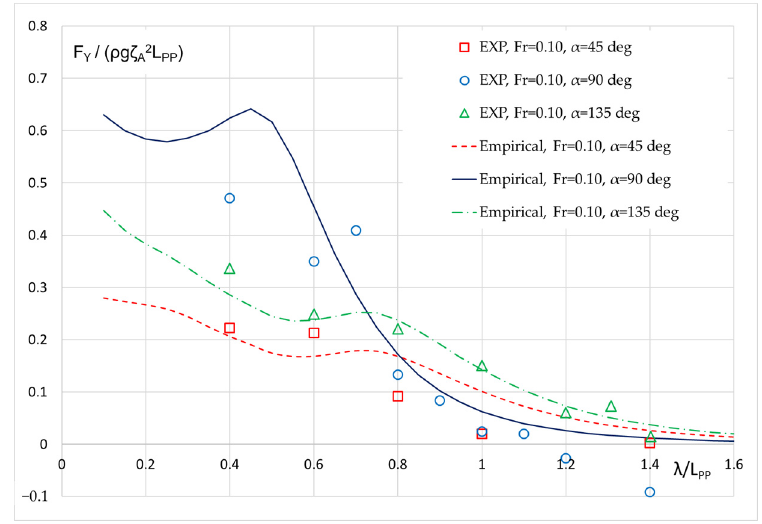
Figure 15. Empirical prediction of the mean sway force of a bulk carrier in waves, Fr = 0.10.